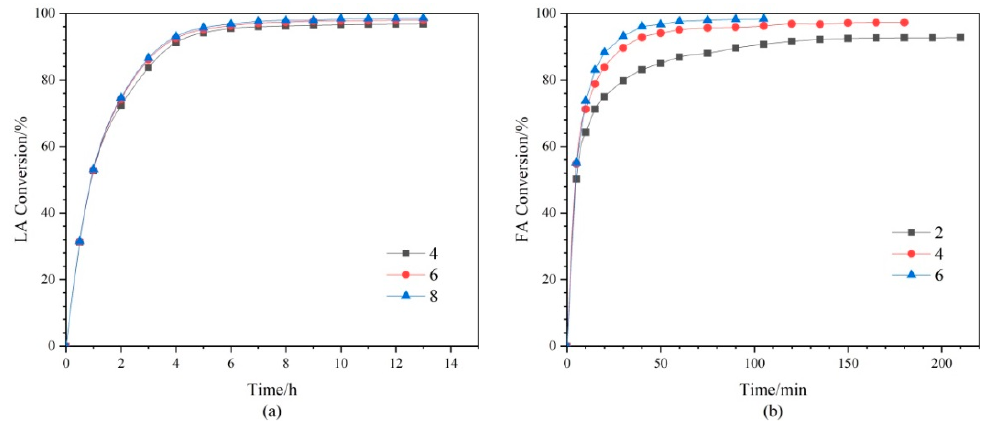
Figure 3. Kinetic data of ( a ) LA with various initial LA concentrations at 363.15 K and ( b ) FA at 353.15 K.